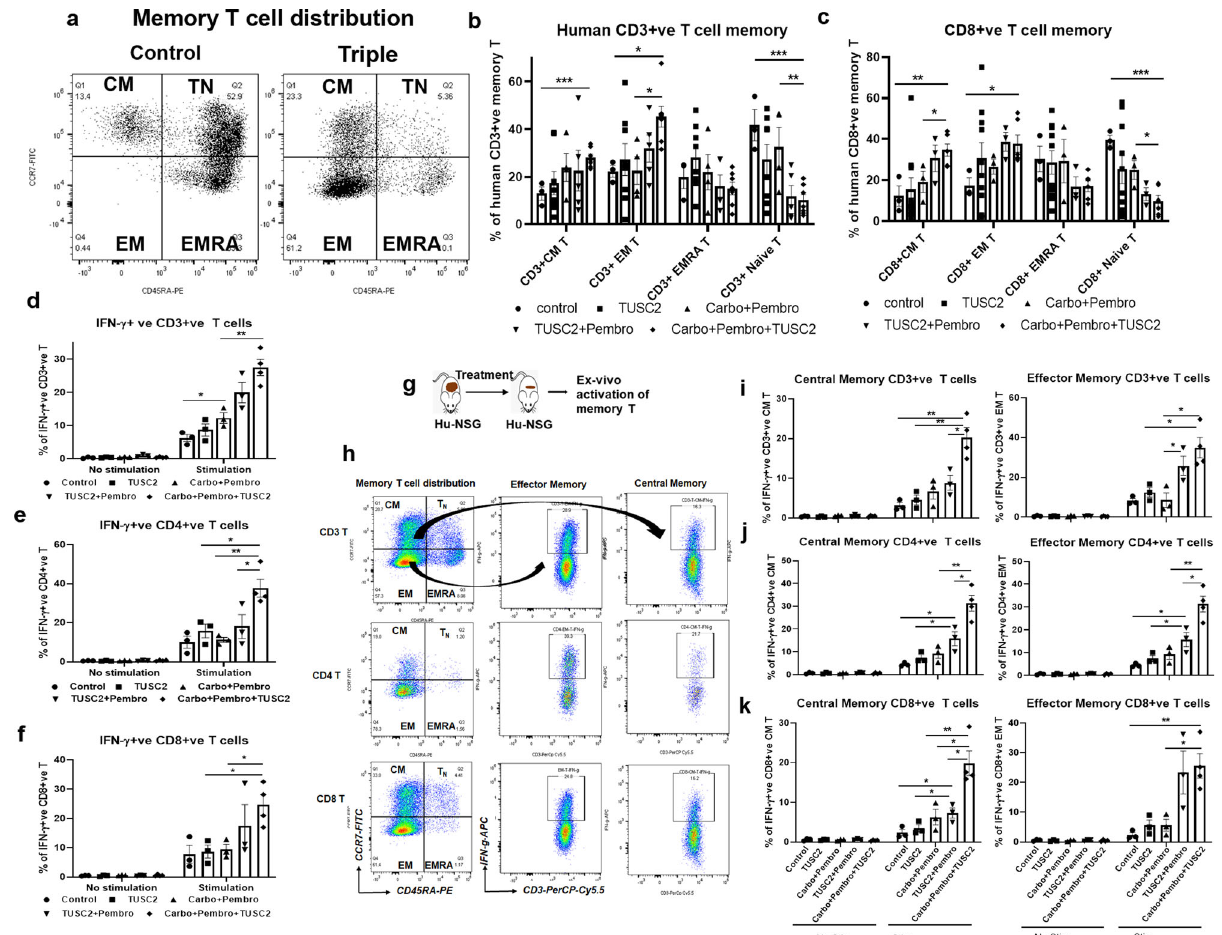
Fig. 6 Distribution of human memory T cells and their ex-vivo activation in KRAS/LKB1 lung metastases in a humanized mouse model. In-depth immune analysis was performed using multicolor fl ow-cytometry using a memory T cell panel in lung metastases and ex-vivo activation of memory T